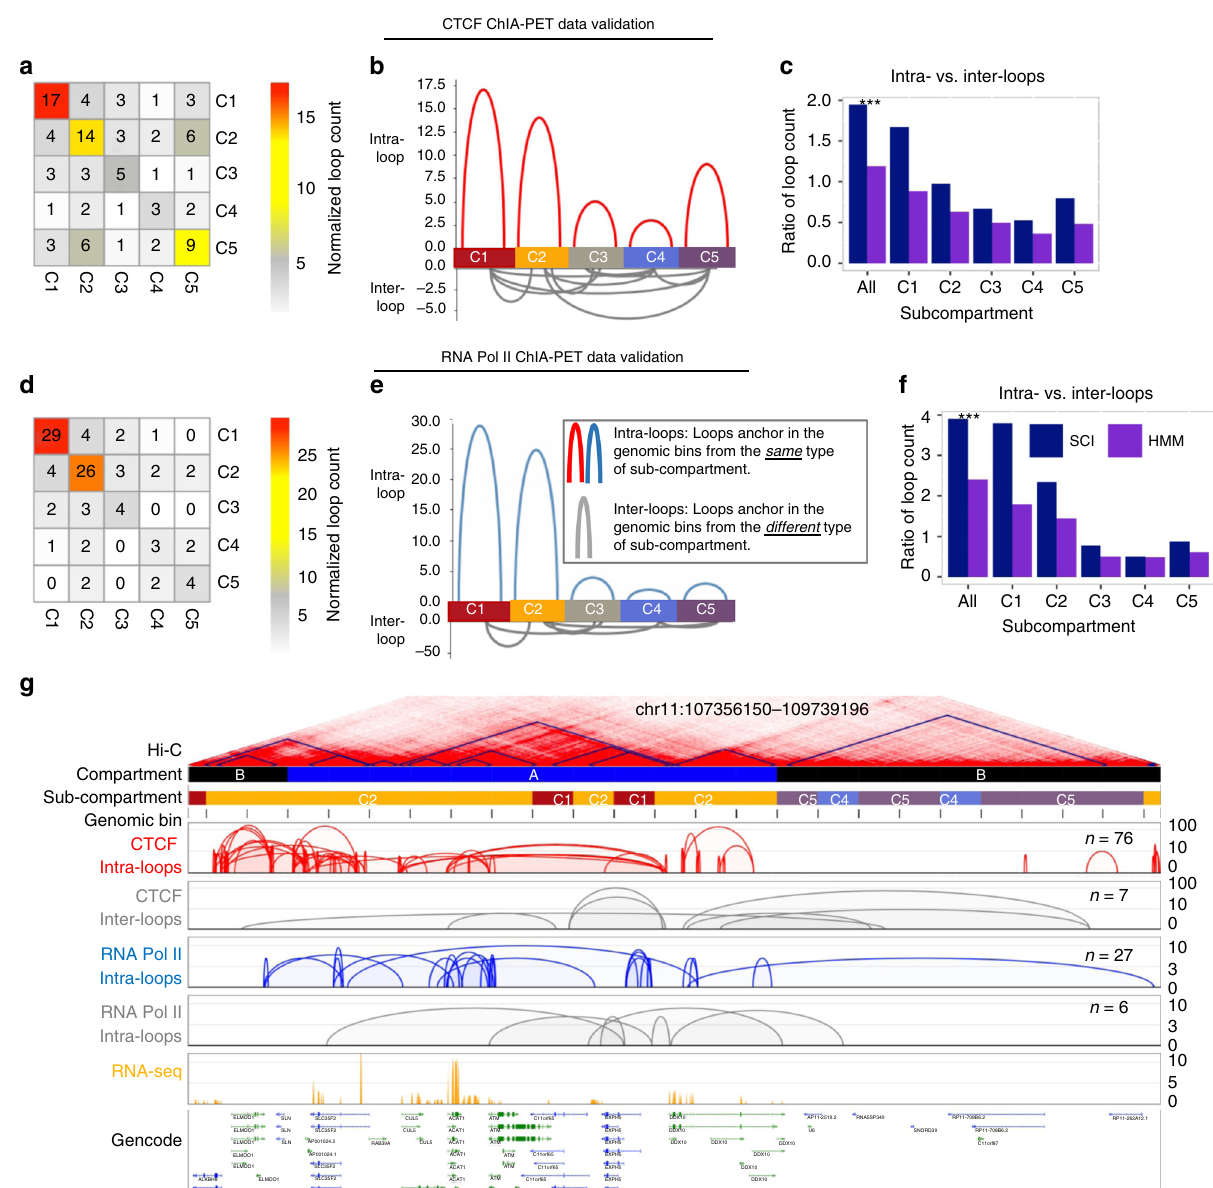
Fig. 2 External validation of SCI-predicted sub-compartments using orthogonal ChIA-PET chromatin interaction data. Validation using CTCF ChIA-PET ( a – c ) and RNAPII ChIA-PET ( d – f ) . a , d Heatmaps of ChIA-PET loop counts per predicted sub-compartment, based on the mapping of loop anchors to genomic bins. Loop counts normalized genome-wide using sub-compartments determined by SCI. b , e Plots visualizing the abundance of ChIA-PET loops across SCI-predicted sub-compartments. c , f Bar plots comparing the ratios of ChIA-PET loops connecting genomic bins within the same sub- compartments to the loops connecting genomic bins from different sub-compartments, based on the sub-compartment predictions by SCI and HMM. g Example regions of SCI sub-compartment predictions that have more intra-sub-compartment loops (intra-loops) than inter-sub-compartment loops (inter-loops) supported by CTCF and RNAPII ChIA-PET. Asterisks (***) represent p -value < 2.2 × 10 − 16 using Fisher ’ s exact